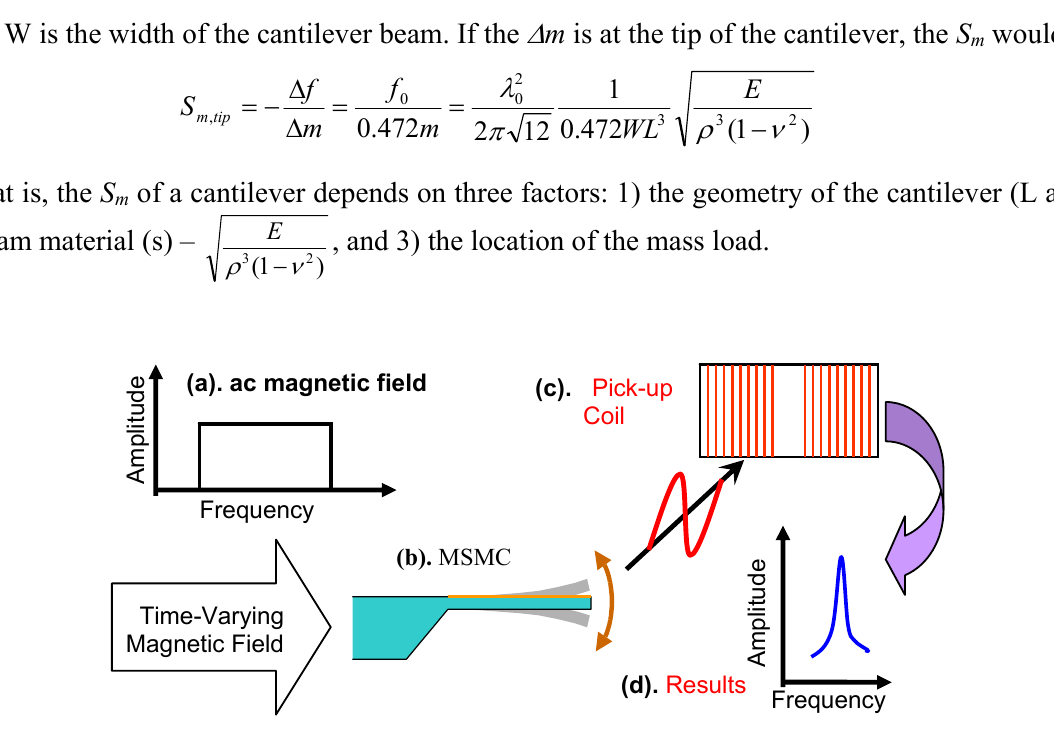
Figure 1. Schematic illustration of the principle of MSMC as a transducer for